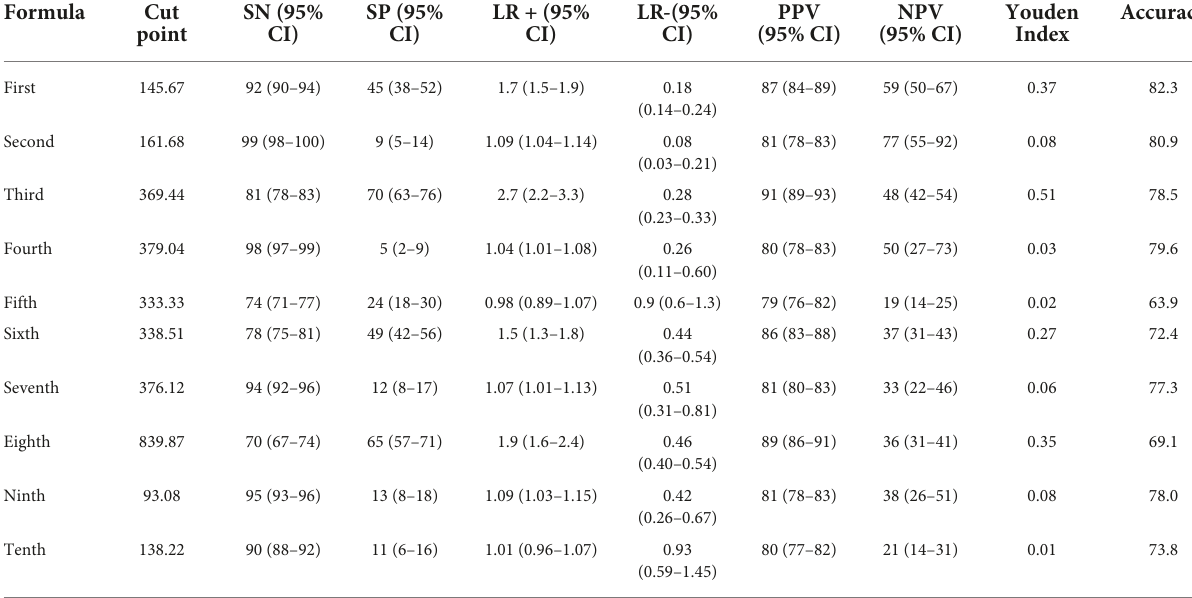
TABLE 4 Diagnostic indices for each proposed new integrated weaning indices based on validation data set.